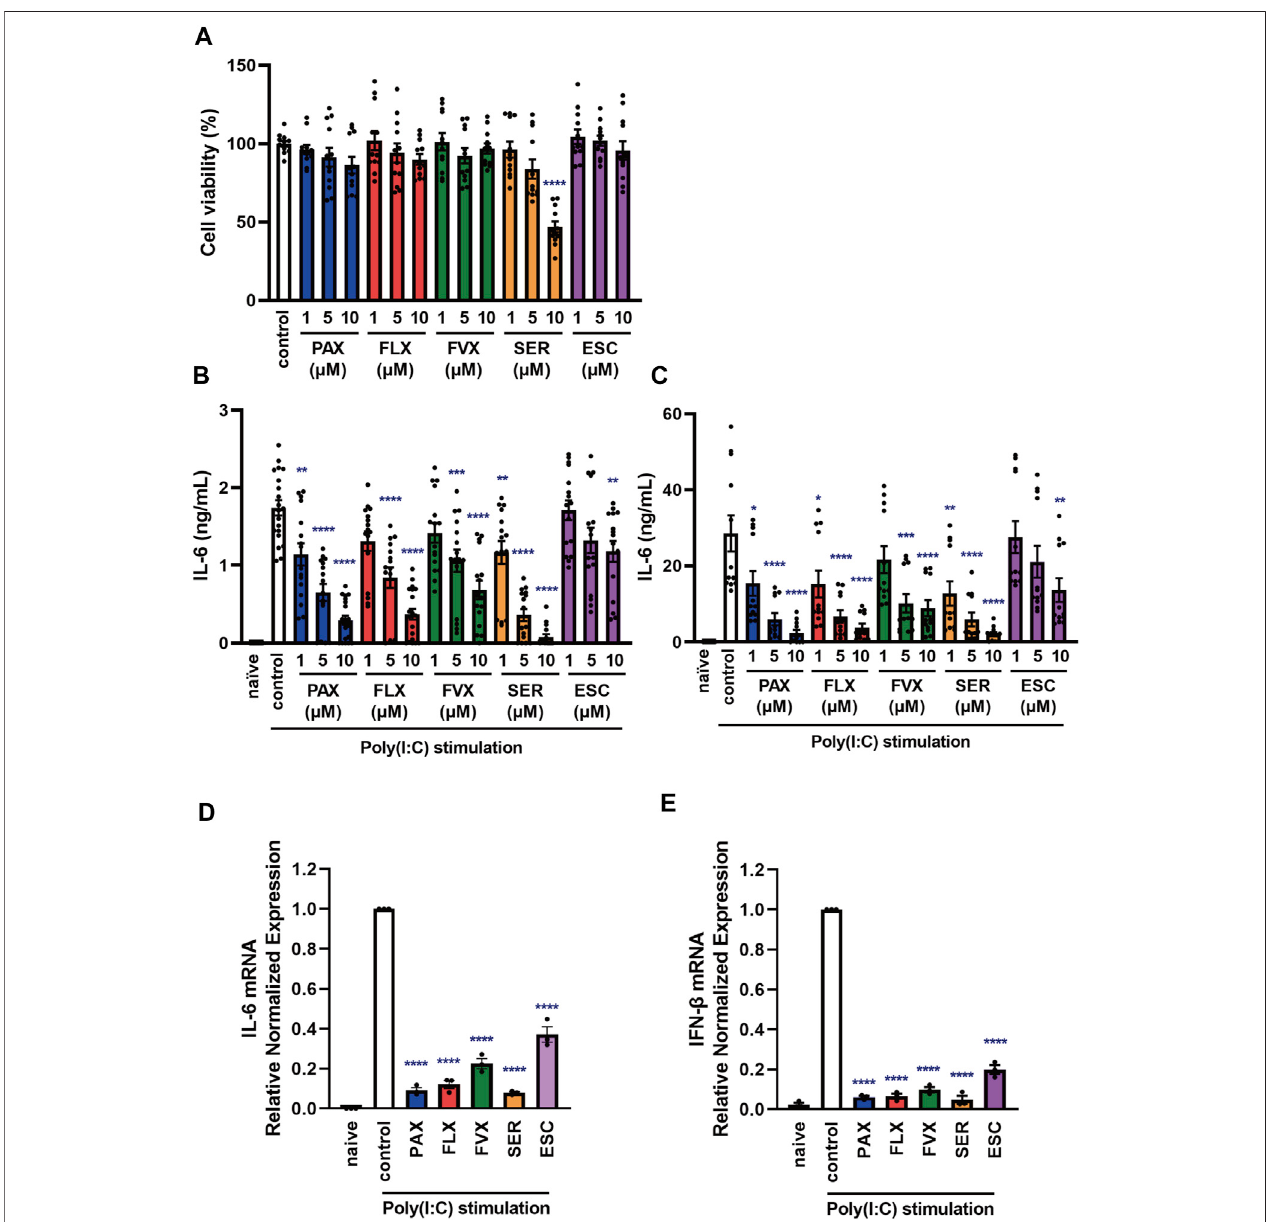
FIGURE 2 | Effects of SSRIs on cytokine production induced by a TLR3 agonist in J774.1 murine macrophage cells. (A) J774.1 cells were incubated with each SSRI(1 – 10 µM) for 24 h. Cell viability wasevaluated byMTT assay. (B,C) Cells werepre-incubated with each SSRI (1 – 10 µM) for 30 min and then incubated with poly(I: C) (5 μ g/ml) for 6 h (B) or 24 h (C) . IL-6 was measured by means of ELISA. (D,E) Cells were pre-incubated with each SSRI (10 µM) for 30 min and then incubated with poly(I:C) (5 μ g/ml) for 3 h. Expression of IL-6 or IFN- β mRNA was analyzed by real-time RT-PCR. Error bars indicate ±SE [ (A) : n = 12, (B) : n = 16 – 20, (C) : n = 12, (D,E) : n =3,threeormoreindependentexperiments].Statisticalanalysiswasperformedbyone-wayANOVAfollowedbyDunnett ’ stest.Signi fi cantdifferencesbetween control and test groups are indicated by * p < 0.05, ** p < 0.01, *** p < 0.001, **** p < 0.0001. PAX, paroxetine; FLX, fl uoxetine; FVX, fl uvoxamine; SER, sertraline; ESC,